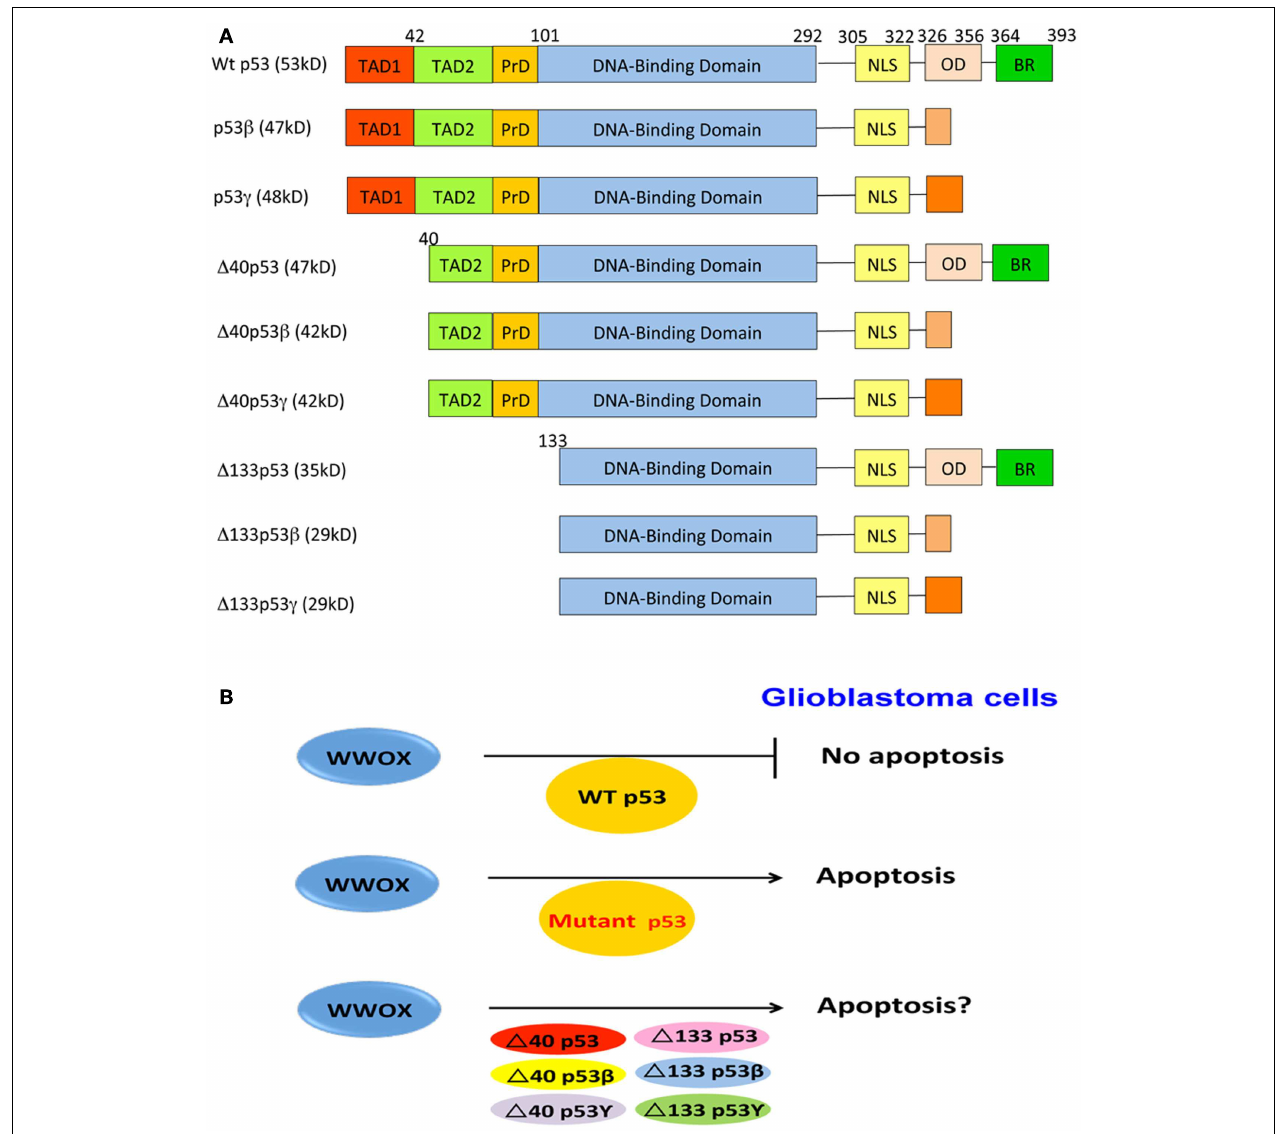
p53, and both proteins nullify each other’s function in inducing apoptosis. Second, no physical interactions between mutant p53 proteins andWWOX are expected in GBM cells.Thus, ectopicWWOX induce apoptosis in mutant p53-expressing cells. Finally, whetherWWOX binds p53 isoforms is unknown. Also, whether ectopicWWOX induction of apoptosis in GBM cells expressing p53 isoforms remains to be established.TAD, transactivation domain; PrD, proline domain; NLS, nuclear localization signal; OD, oligomerization domain; BR, basic